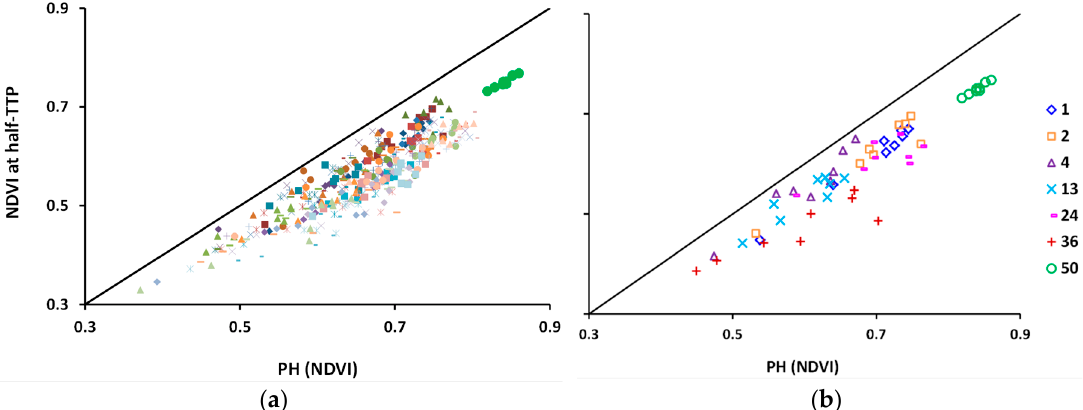
Figure 9. Annual phenometrics of NAHT as a function of PH NDVI : ( a ) for all study sites; and ( b ) selected study sites for 2003–2010. Sites are numbered according to their latitudinal position from south (1) to north (50) (Figure 1).